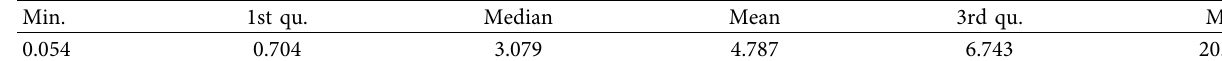
Table 3: The summary measures of COVID-19 data.